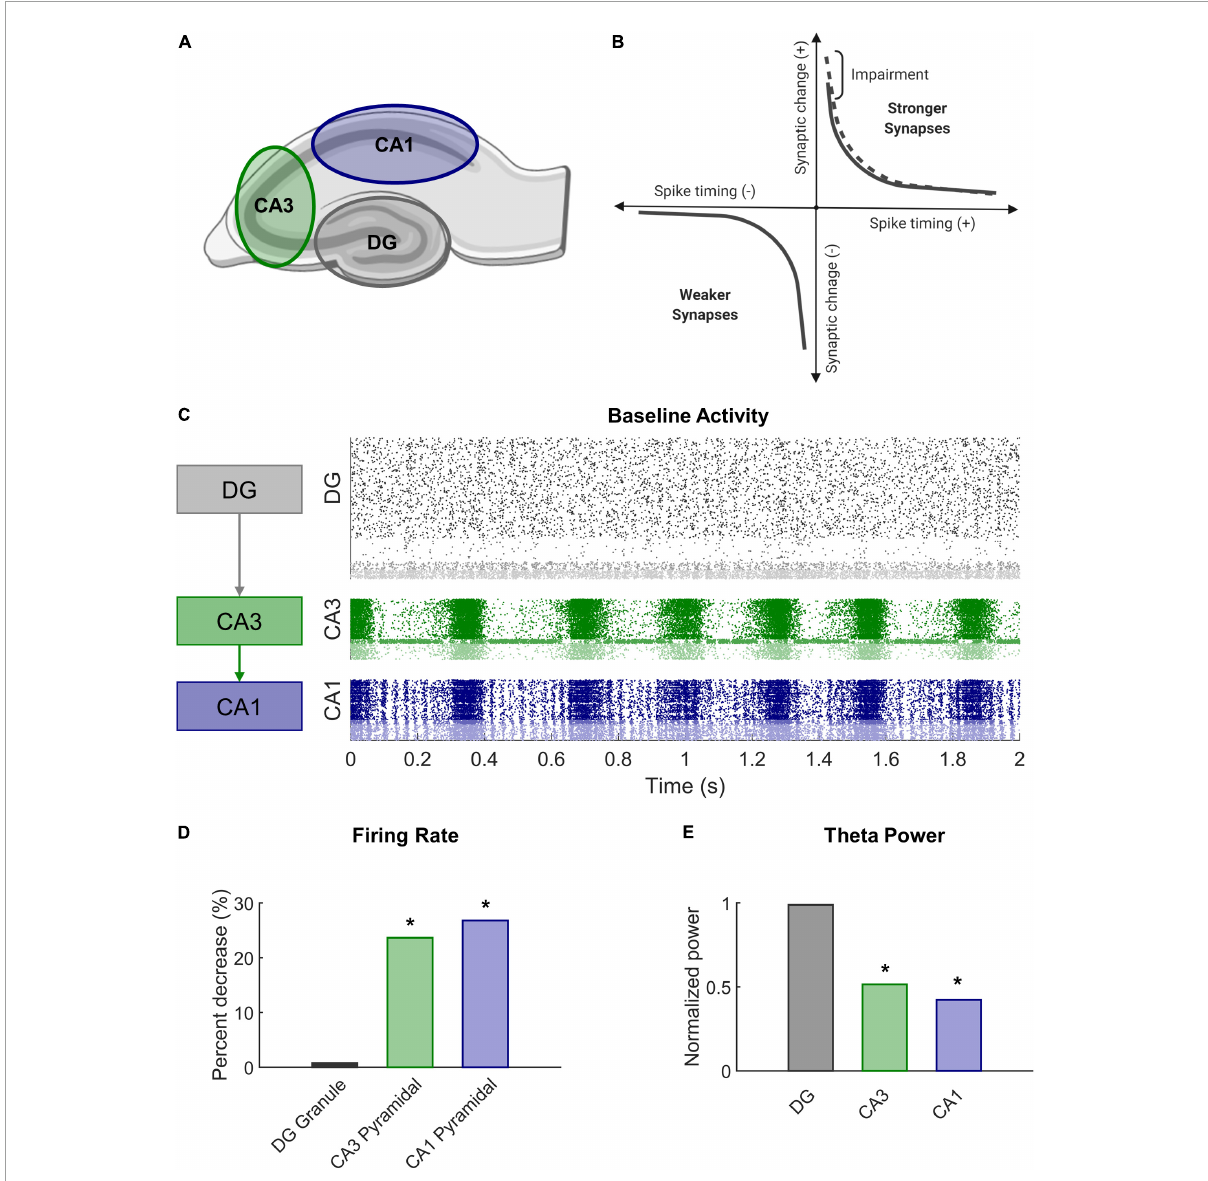
FIGURE1 Modeling STDP impairment in a network model of the hippocampus. (A) The hippocampus consists of several regions connected in a predominantly feedforward topology with information passed from the DG to CA3 to CA1. These three regions are represented in the network model. (B) According to classical STDP, synapses between neurons with causal spikes (positive spike timing) are strengthened, but synapses between neurons with acausal spikes (negative spiking timing) are weakened. With STDP impairment, peak strengthening, or potentiation, is decreased. (C) At baseline, each region has a distinct pattern of firing activity. (D) After STDP impairment, firing rate significantly decreased in areas CA3 and CA1. (E) The power in the theta band, which is important for information processing and hippocampal function, also significantly decreased after injury. * p <